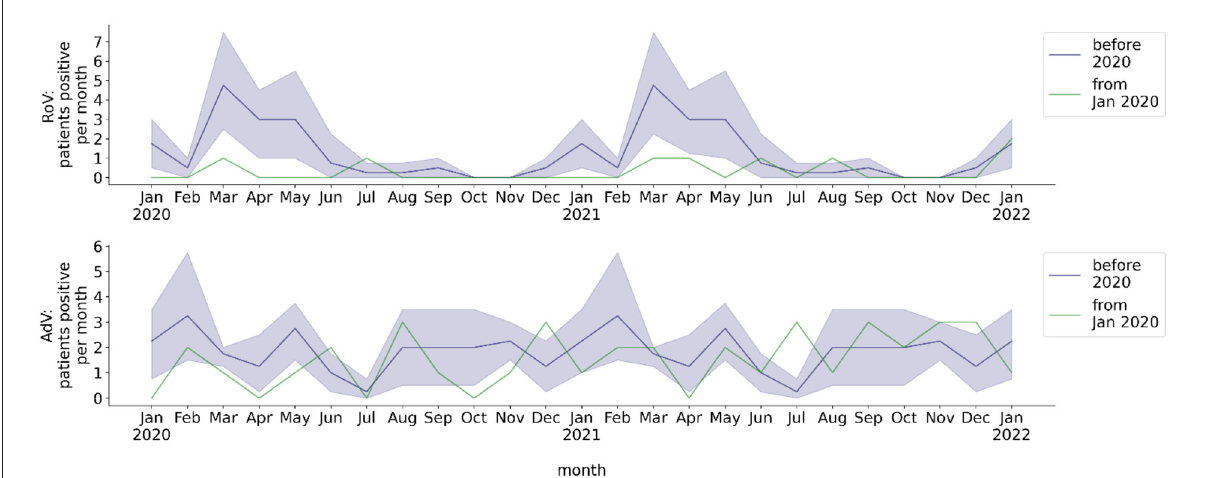
FIGURE4 Monthly number of hospitalized patients at BCH positively tested for gastrointestinal viruses. Blue line: mean 2016-2019, blue shade: 95% confidence interval 2016-2019, green line: absolute number per month from 2020, calendar months 2016-2019 are shown as a historical reference and correspond to calendar months, not to year on x-axis. Number of patients per month with stool sample tested positive for RoV or AdV.